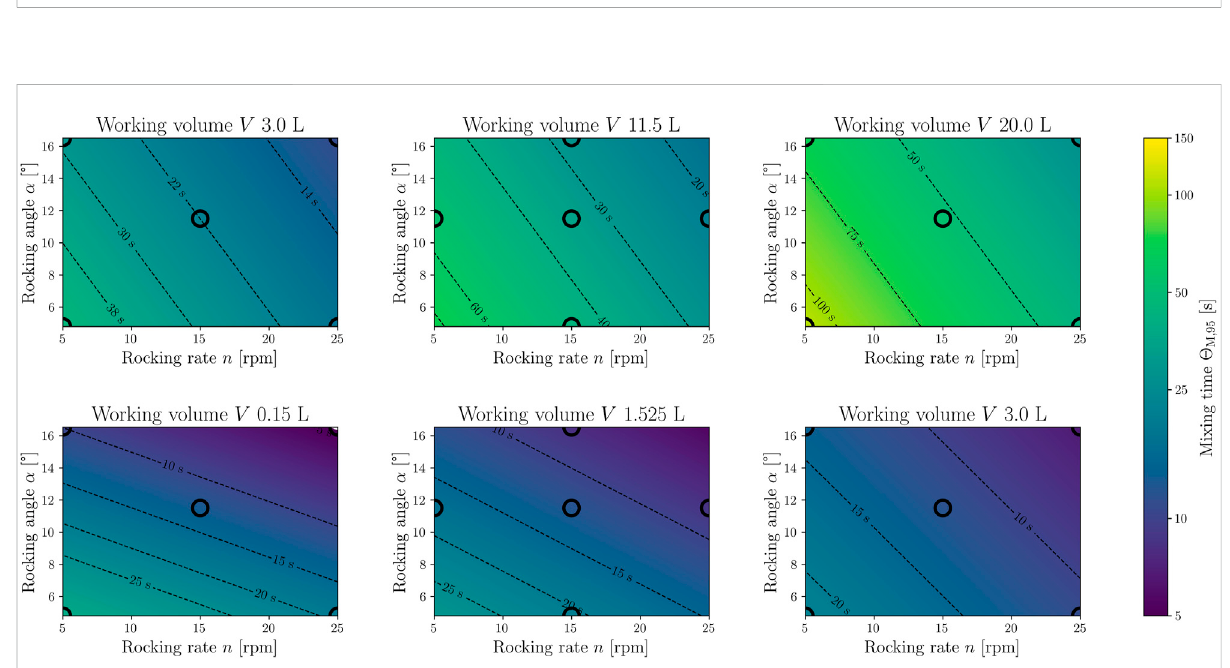
FIGURE 12 Response surface model (RSM) for the global mixing time Θ M,95 . The top row shows the model for the standard CELL-tainer con fi guration ( N = 15, DF =9, R 2 =0.88, RMSE =1.45 s)withthreedifferentworkingvolumes(3.0L,11.5Land20.0 L).ThelowerrowshowstheRSM( N =15, DF =9, R 2 = 0.89, RMSE = 1.18 s) for the con fi guration with expansion channels (0.15L, 1.525L and 3.0 L). The black circles mark process parameter settings on which CFD simulations were performed to create the model, and the fi lling color corresponds to the exact value of the CFD